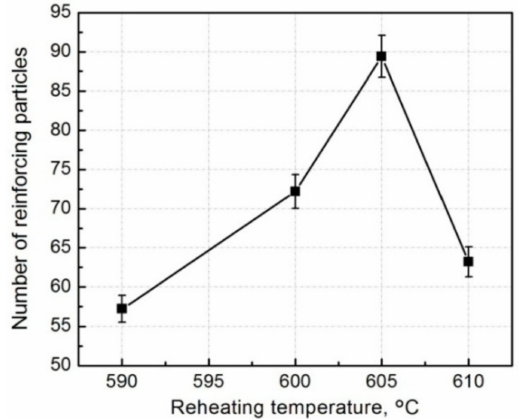
Figure 12. Variation of visible reinforcement number on the fracture surfaces vs reheating